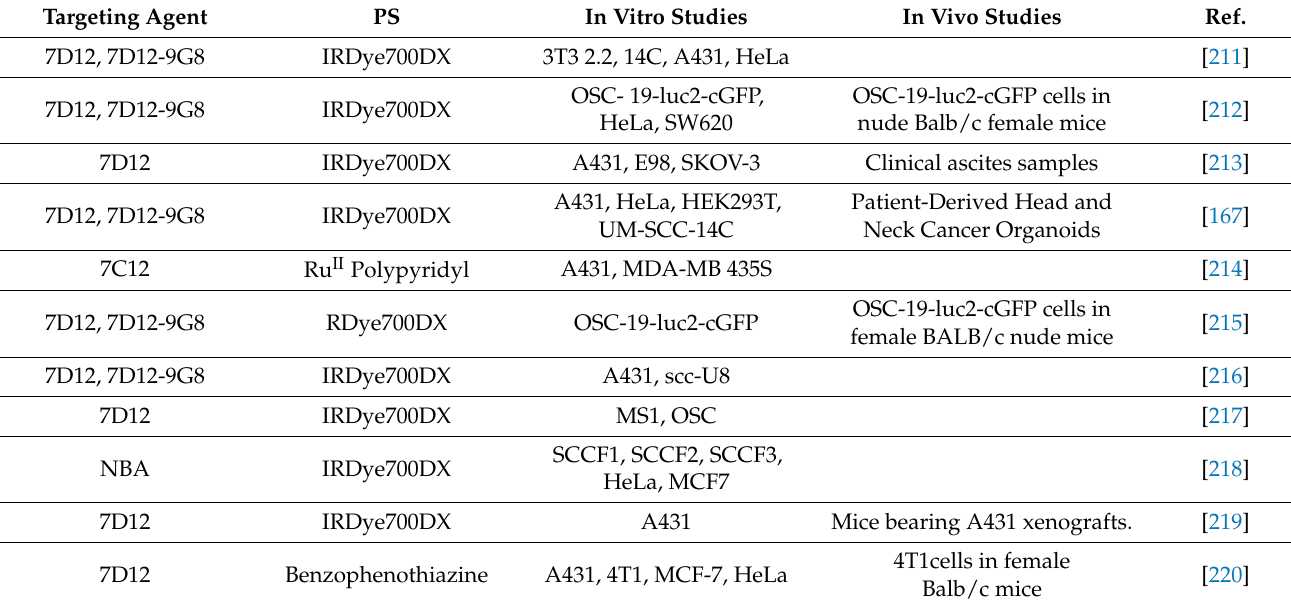
Table 10. EGFR-targeted PDT performed with anti-EGFR